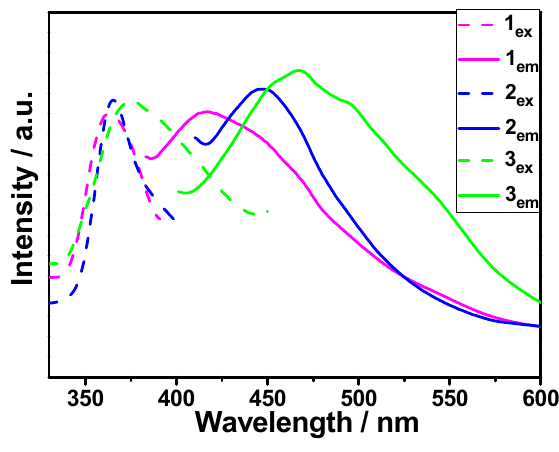
Figure 6. Luminescent properties of 1 – 3 .